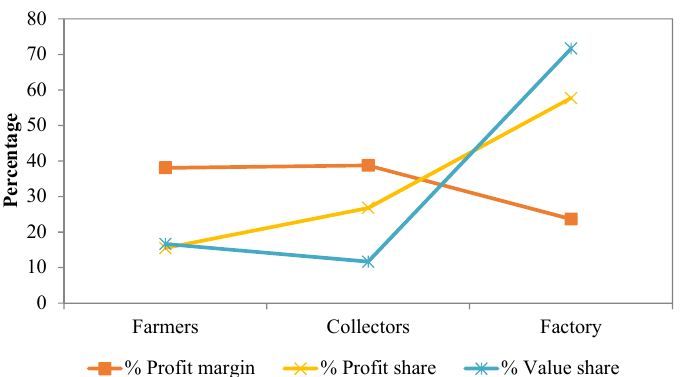
Figure 2. Profit and added value for different stakeholders throughout the banana chips value chain Figure 2. Pro fi t and added value for di ff erent stakeholders throughout the banana chips value in business-as-usual chain in business-as-usual case.